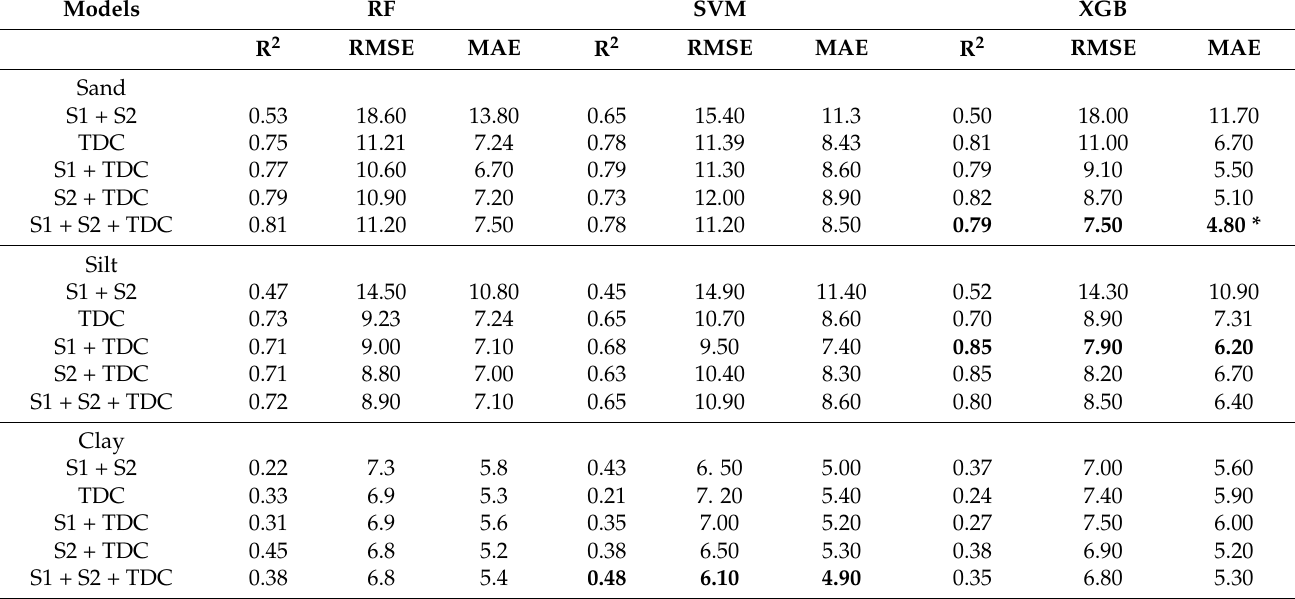
Table 4. Model accuracy for soil texture fractions in the K